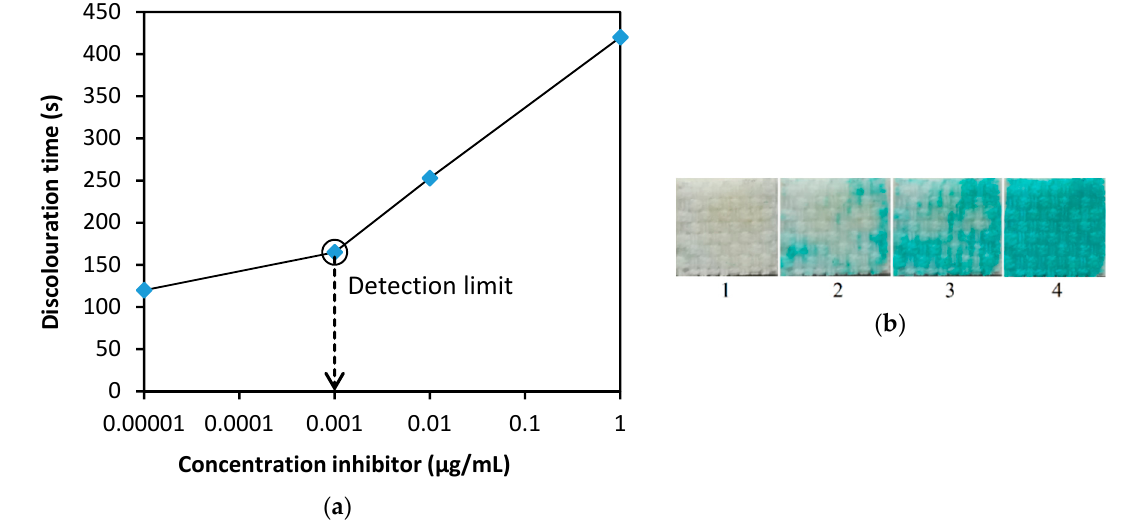
Figure 5. ( a ) Dependence of discoloration time on concentration—the average values of GB, GD, GF and VX were used to construct the graph, see Table 1, ( b ) dependence of color intensity (appearance of indicator zone) on inhibitor concentration at the control time T 0 = 120 s (1—blank, 2—0.001 µg/mL, 3—0.01 µg/mL, 4—1 µg/mL). Note: the curve in figure is based on a fit of data points.